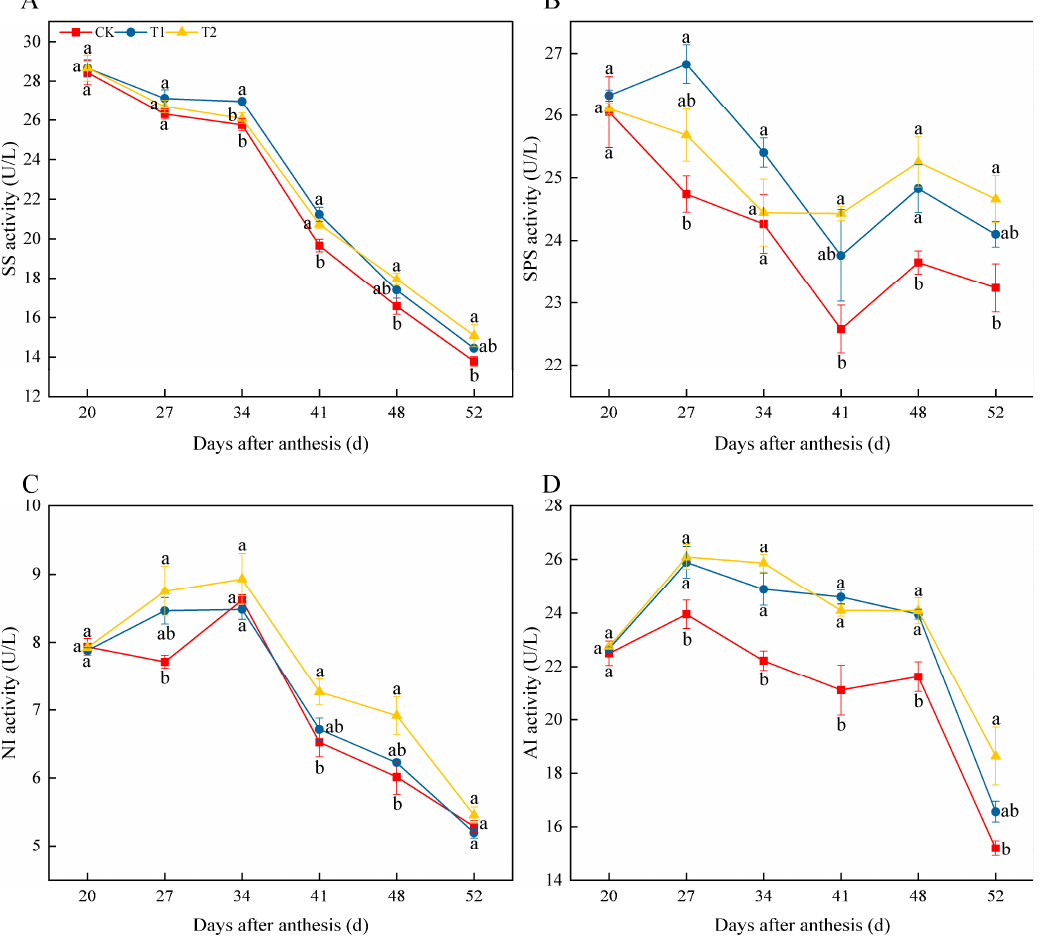
Figure 5. Effects of exogenous melatonin on the activities of enzymes in sucrose metabolism in tomato fruit. ( A ) The activity of sucrose synthase (SS). ( B ) The activity of sucrose phosphate synthase (SPS). ( C ) The activity of neutral invertase (NI). ( D ) The activity of acid invertase (AI). Results are means ± SE of three independent replications. Different letters represent significant differences between treatments ( p < 0.05).